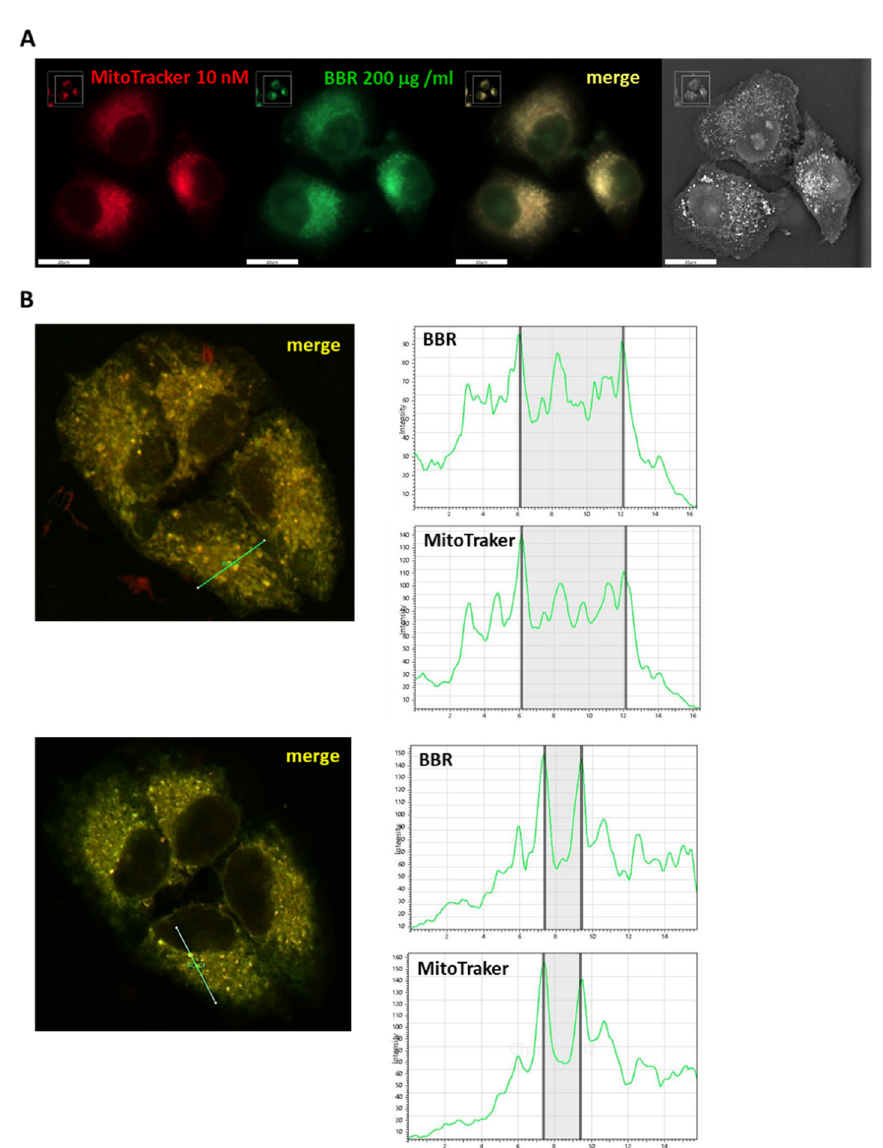
Figure 3. BBR and mitochondria co-localization. T98G cells were incubated for 4 h with BBR (200 μ g/mL) and analyzed after 24 h p.t. Before microscopy examination, cells were treated with 10 nM MitoTracker deep Red (Thermofisher) for 45 min and then visualized using a Nanolive microscope, scale bars = 20 μ m ( A ). Co-localization analysis was performed using confocal microscopy, reporting histograms of BBR and MitoTracker profiles ( B ).